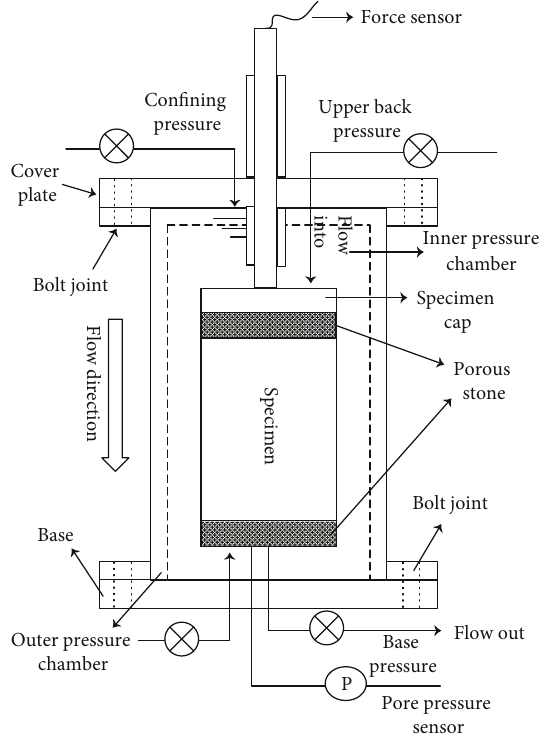
Figure 2: Schematic diagram of pressure application for consolidation and permeability tests. Table 2: Scheme and procedure of staged consolidation test. Consolidation